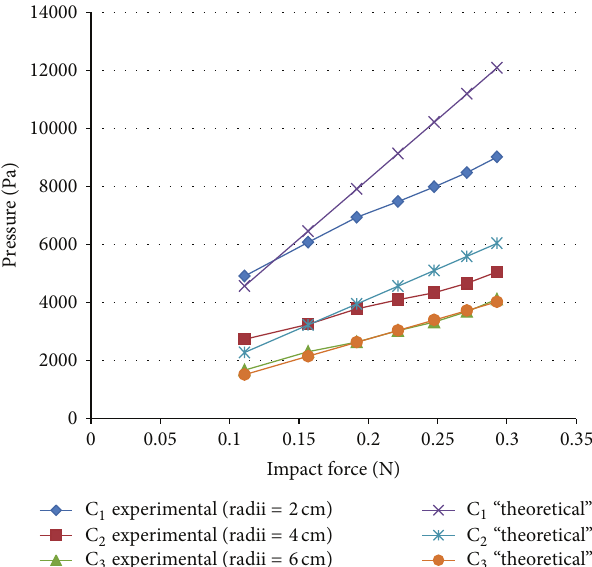
Figure 13: Experimental and theoretical results of the pressure on the sensor versus the impact force